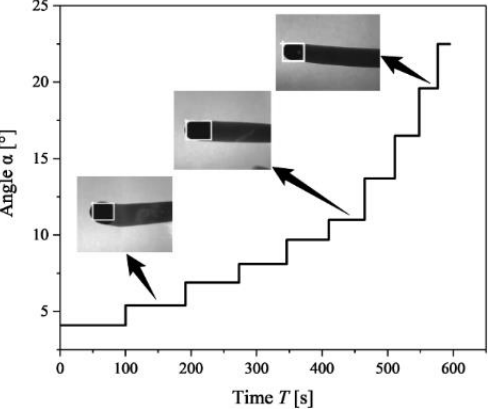
Figure 4. Measuring time and flow images under different angles.